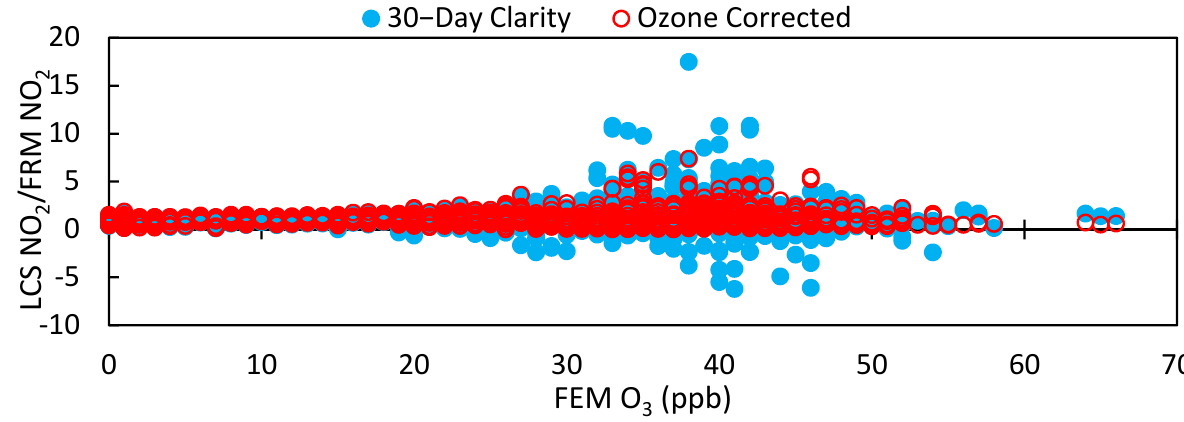
Figure 2 . Ratio of LCS NO 2 values to FRM NO 2 values vs. FEM O 3 for the Clarity 30-day calibration and the Ozone corrected 30-day calibration.